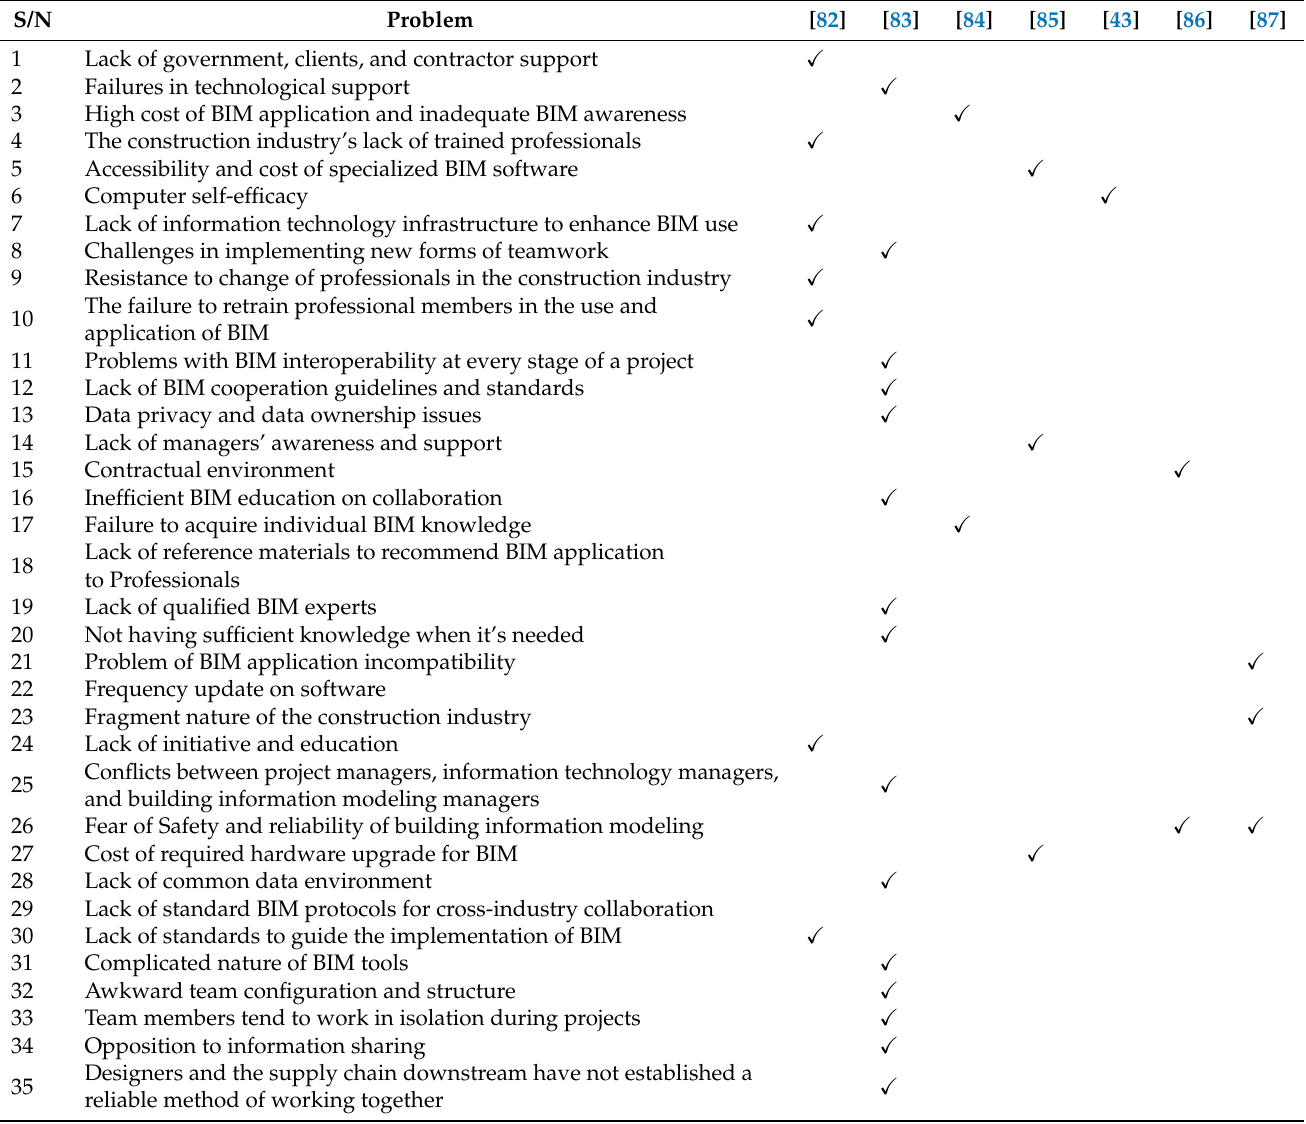
Table 1. Problems that have been preventing the building industry from fully adopting BIM